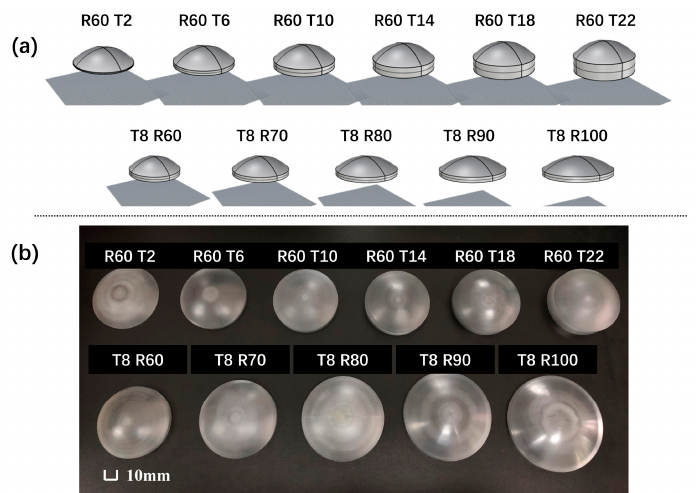
Figure 2. ( a ) CNC-printed prototypes; ( b ) physical map of the acrylic plate (unit: mm).